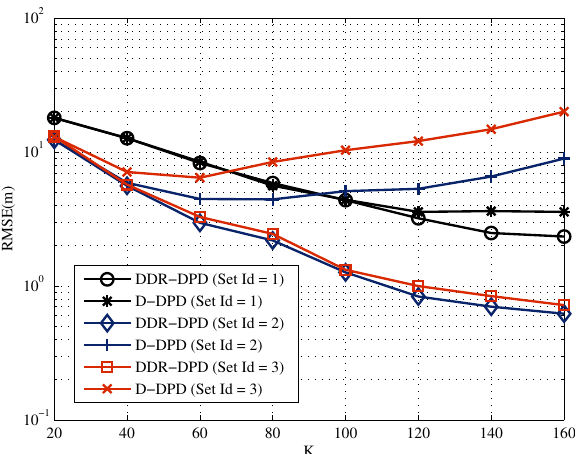
Figure 8. RMSE vs. pulse number in each coherent pulse train.